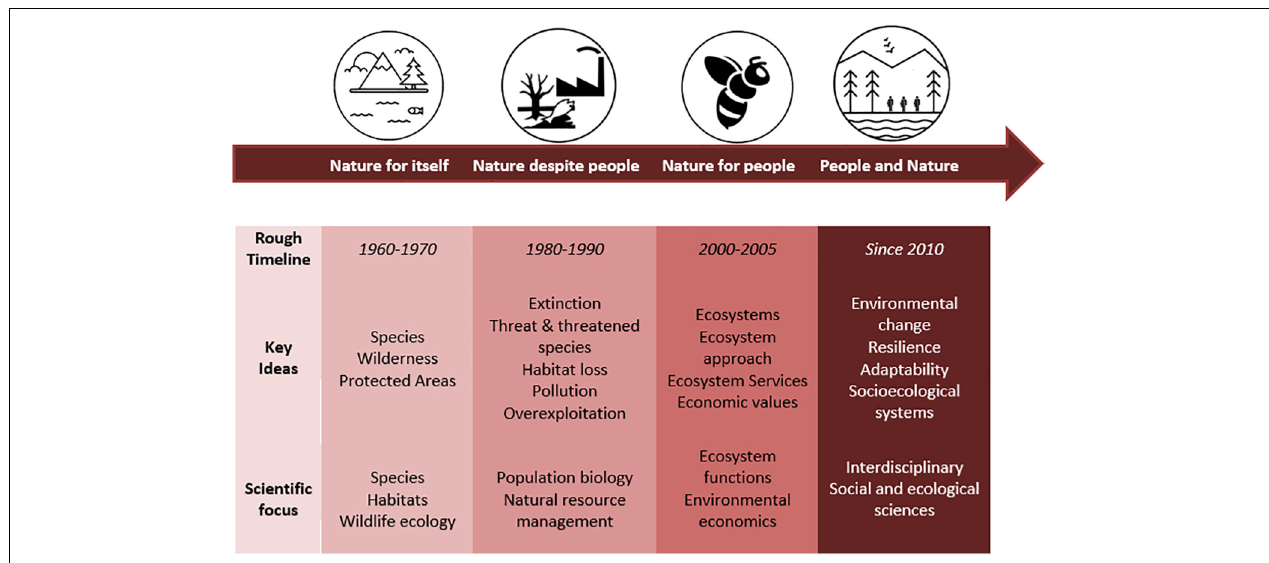
FIGURE 1 | Changes in the philosophical framing of conservation over 50 years and the resulting shifts in practical focuses (adopted from Mace, 2014).